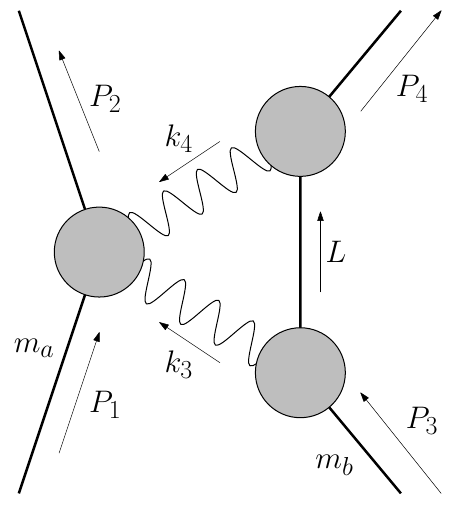
Figure 2 . The triangle cut used to compute the 2 PM